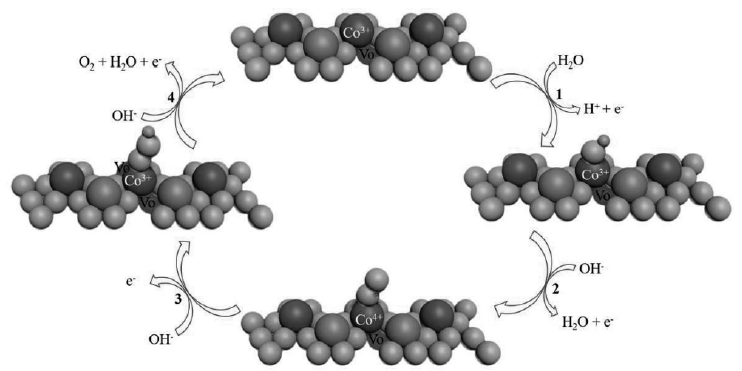
Figure 23. Proposed OER mechanism of a Co 3+ active site, near an oxygen vacancy in Fe x Co y ‐ O nanosheets. Reproduced from [72], with permission from John Wiley and Sons, copyright